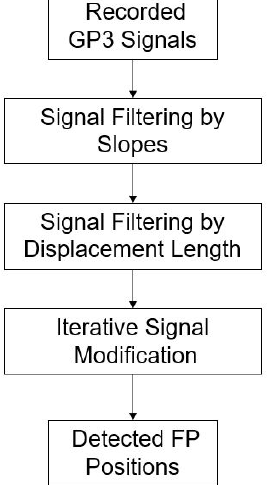
Figure 2. Flowchart of proposed fast phase (FP) position detection.